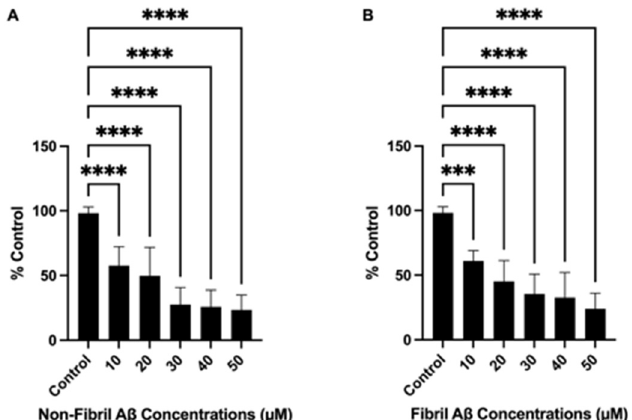
Figure 2. Effects of beta-amyloid (A β ) 25–35 on cell viability. Cell viability, represented as % control, is shown on the y-axis, and A β 25–35 concentrations are displayed on the x-axis. The bars represent the mean ± standard error of the mean (SEM) of six independent experiments. Cells were incubated with increasing concentrations (10, 20, 30, 40, and 50 μ M) of non-fibril ( A ) or fibril ( B ) A β 25–35 . Non-fibril and fibril A β 25–35 reduced cell viability in a dose-dependent manner. Statistical significance vs. controls was assessed using one-way analysis of variance (ANOVA). *** p = 0.0001; **** p < 0.0001.